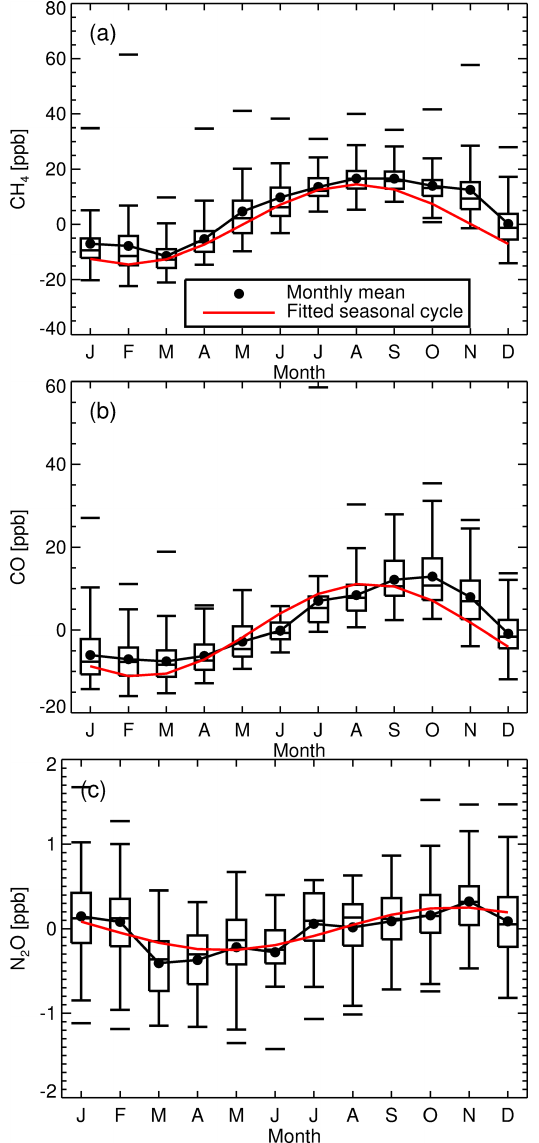
Figure 16. Box plot statistical summaries of detrended monthly baseline measurements of CH 4 (a) , CO (b) and N 2 O (c) over the period 2007–2017. The fitted seasonal cycle (1 Fourier pair) is over- laid as a solid red